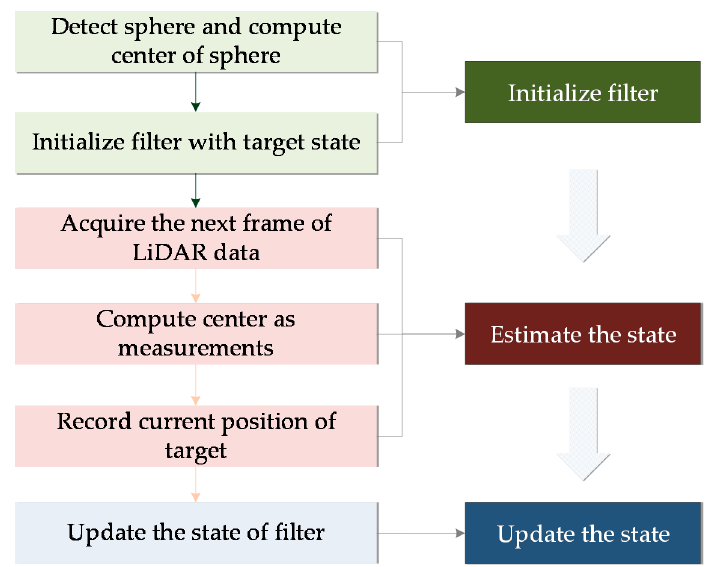
Figure 10. Sphere motion tracking process with KF based on LiDAR.